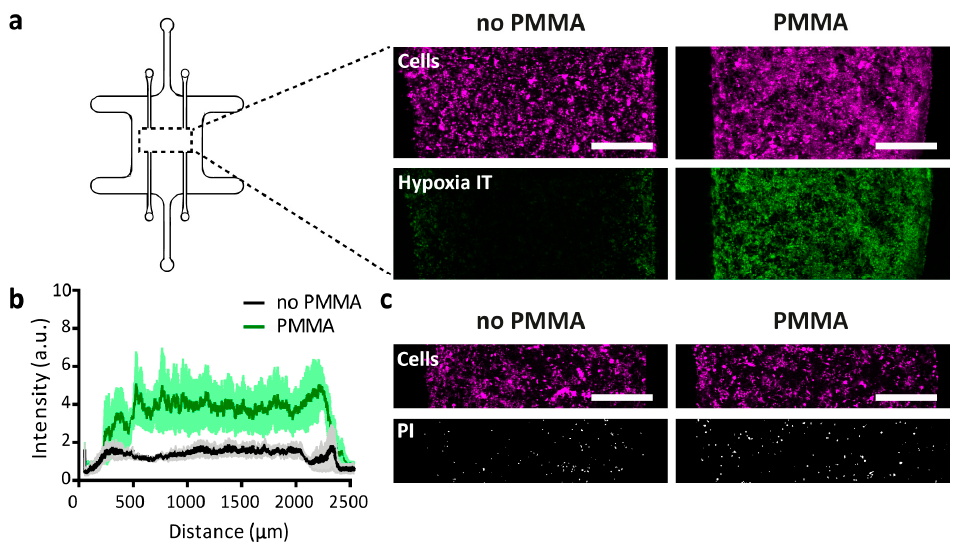
Figure 3. Evaluation of the generation of hypoxia in the microfluidic device. (a) 3D tumor cultures of collagen and U-251 MG cells were loaded in devices with or without embedded PMMA sheets, and incubated with the oxygen-sensitive dye ImageIT (green). U-251 MG cells were stained with CytoTell Red (depicted in magenta here). The scale bars represent 500 μ m. (b) Quantification of the intensity of ImageIT for devices as described in panel a . Lines depict averages at distinct positions in the devices and the shaded areas indicate the standard error of the mean (s.e.m.), n = 3. (c) Pictures showing similar cell densities of U-251 MG cells (Cytotell Red, magenta) and comparable numbers of PI-positive cells (white) in devices with or without the PMMA sheet. The scale bars represent 500 μ m. Under hypoxic conditions, Ayuso et al. already noticed a significant necrotic core generation after 48 h of growth in a 2 mm-wide polystyrene device for HCT-116 and U-251 MG cells at the same loading density of 40 × 10 6 million cells/mL in collagen [16]. Since their device was fabricated using an oxygen-impermeable material, their study did not include any control device without hypoxia, so